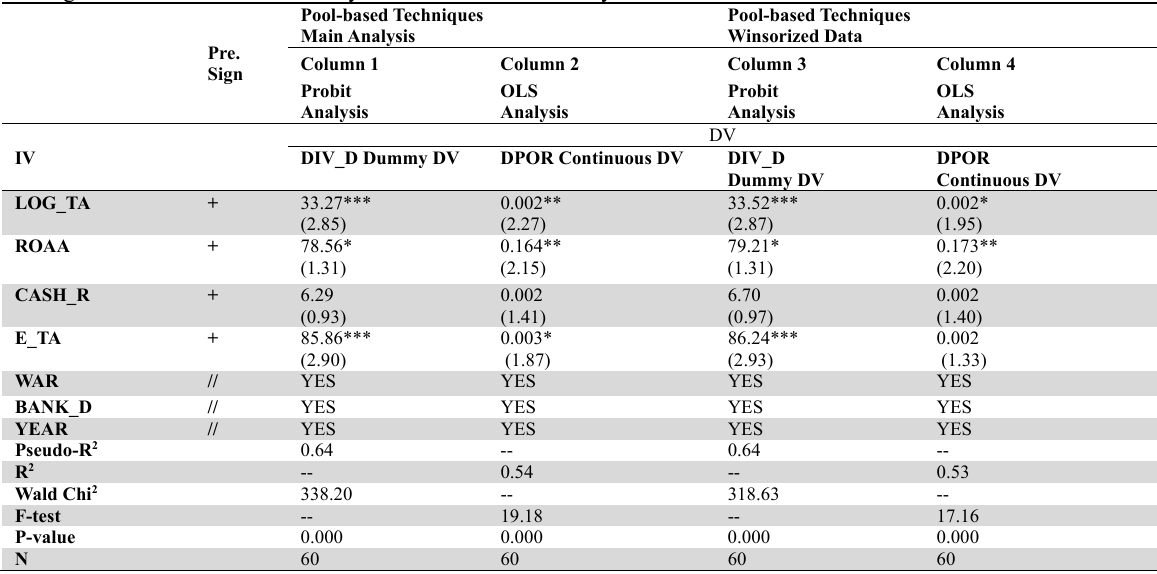
Findings of the Probit and OLS Analyses on the Dividend Policy Determinants in Palestinian Banks 2010–2019 Pre.